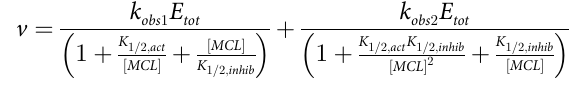
PLOS ONE | https://doi.org/10.1371/journal.pone.0204538 December10,